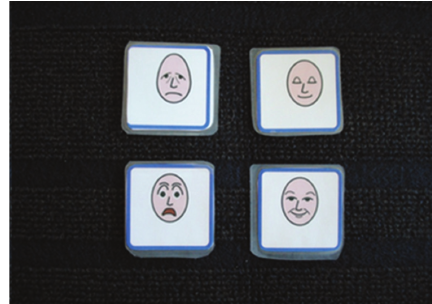
Figure 1: Four faces using Widgit Rebus symbols.